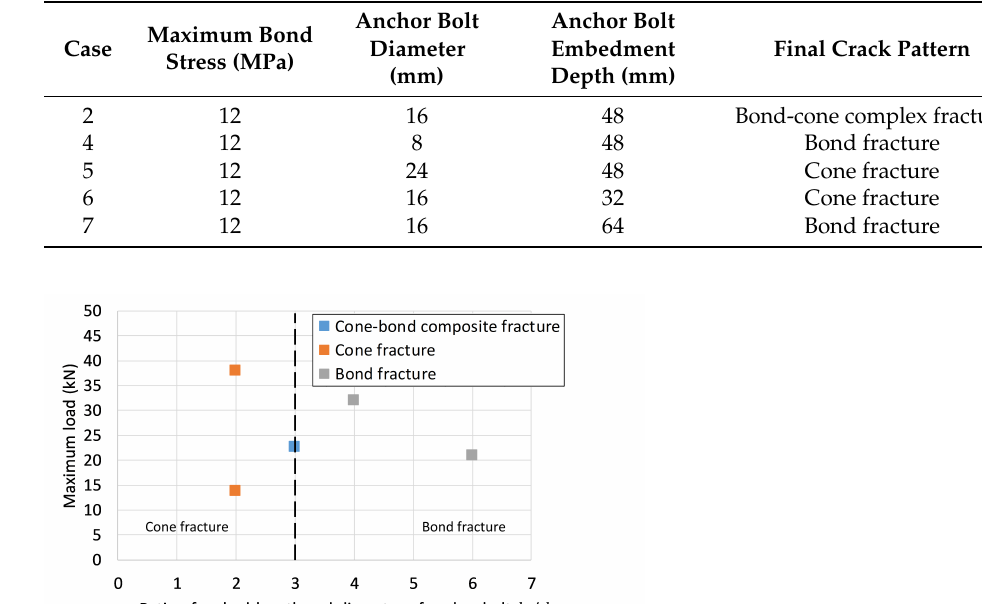
Table 5. Analysis cases and final crack pattern.